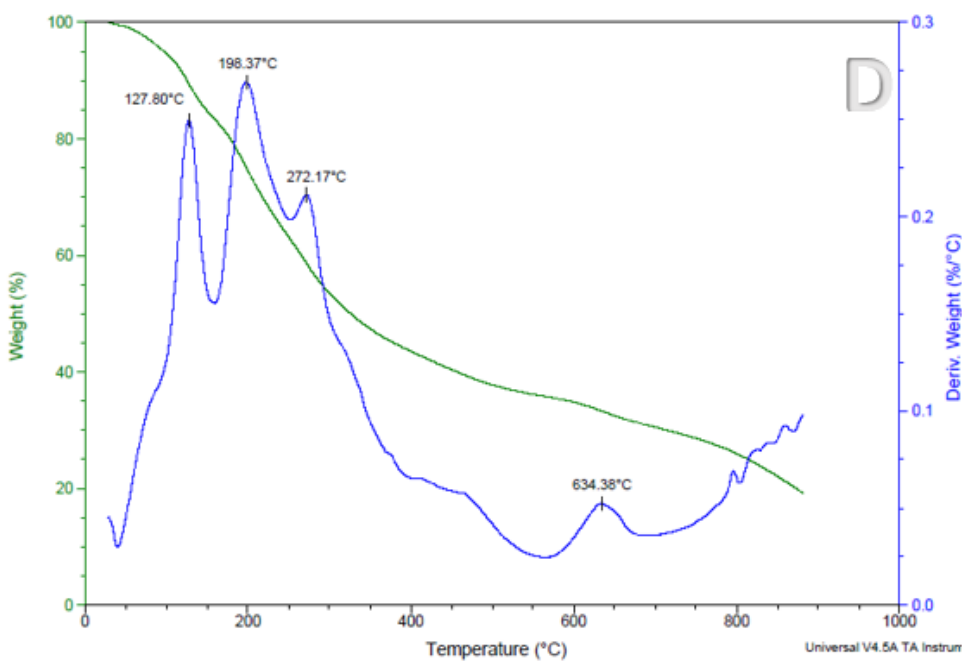
Figure 5. Curves of thermogravimetric analysis of treatments from alginate beads ( A ), alginate: xanthan gum beads ( B ), alginate: pectin beads ( C ) and alginate: psyllium mucilage beads ( D ).